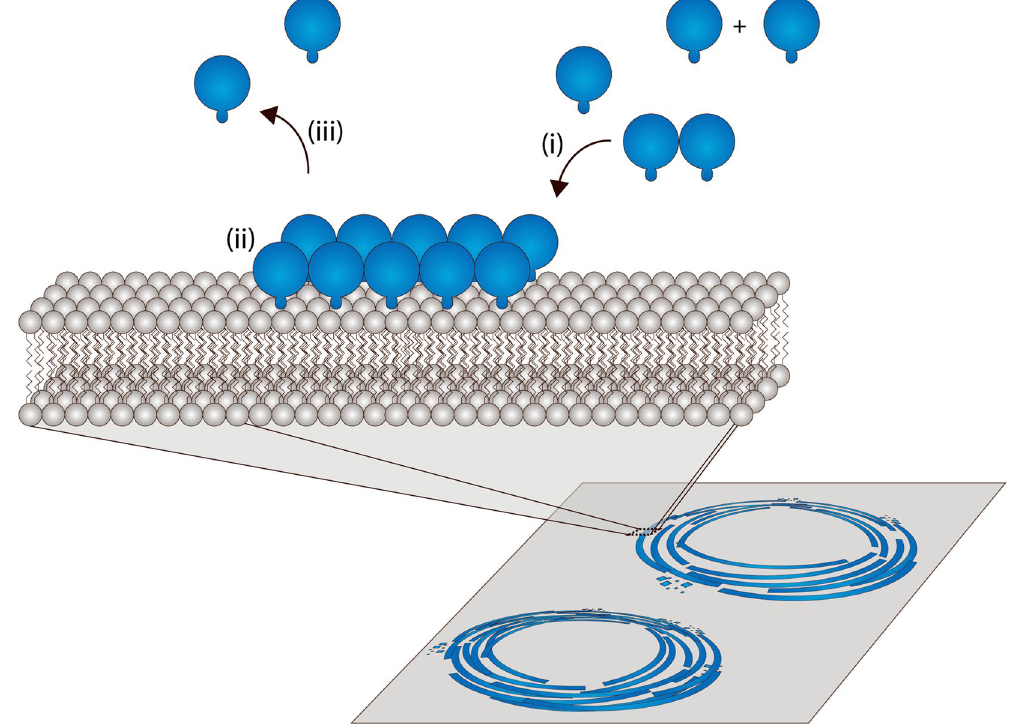
Figure 5. FtsZ ring dynamics depends on three factors: membrane binding, lateral interactions and GTPase activity. GTPase activity 12 and strength of membrane binding will influence the ON (i) and OFF (iii) rates of FtsZ monomers or protofilament on the membrane. Once attached to the lipid interface (ii), lateral interactions will influence ring formation. The interplay of these three factors will determine the treadmilling speed of FtsZ-